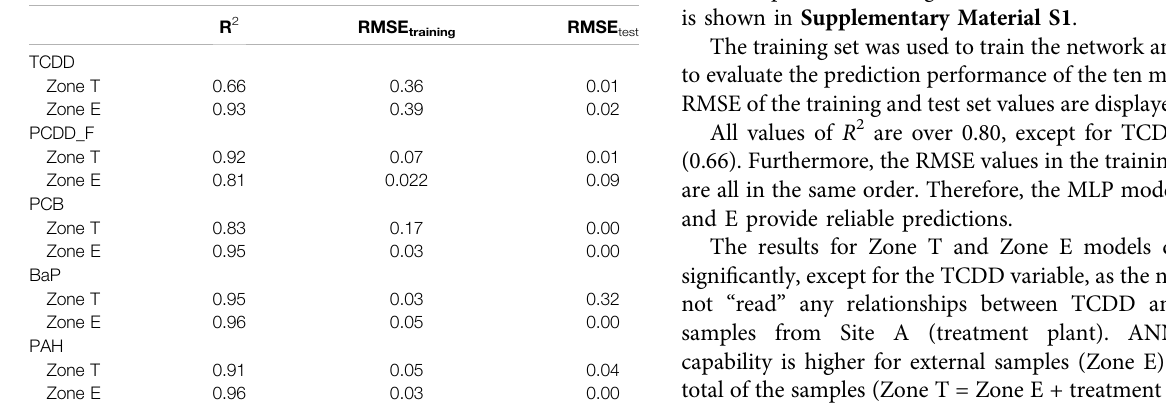
TABLE 2 | ANNs performance evaluation.